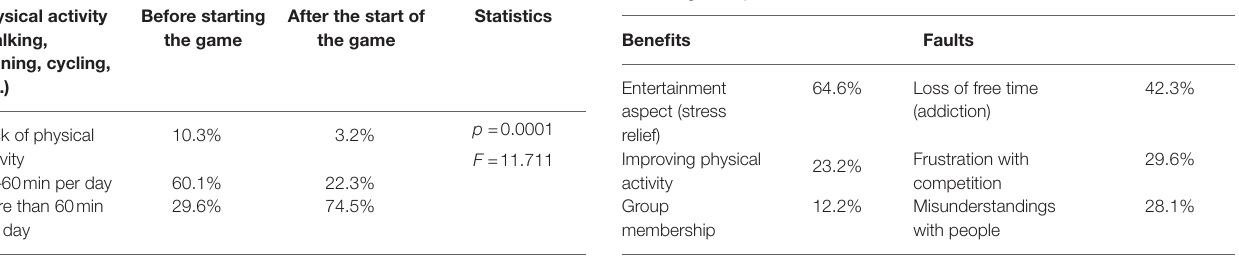
TABLE 3 | Advantages and disadvantages of urban multimedia games according to